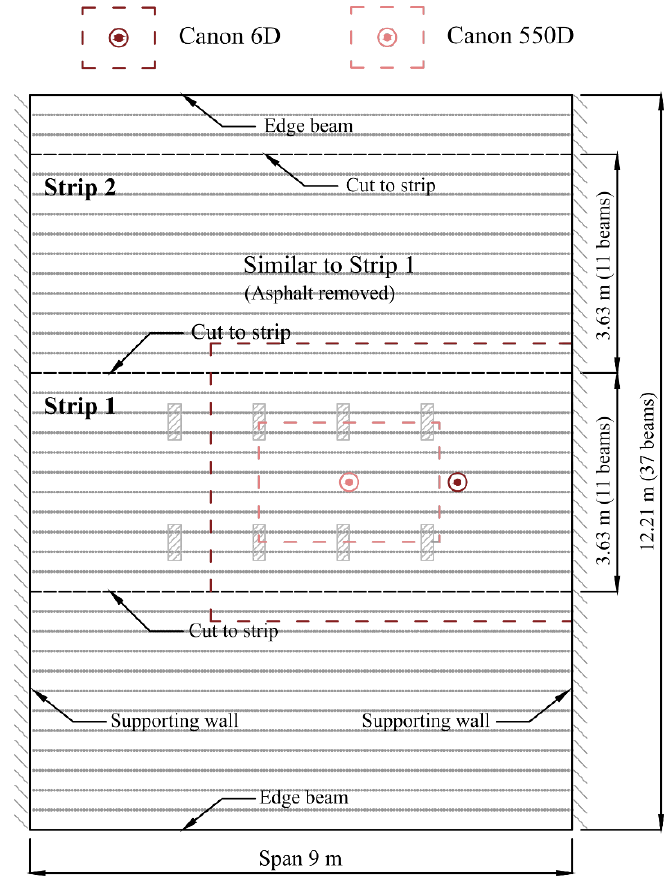
Figure 3. Plan drawing of the two strips and the position of load and DIC cameras.